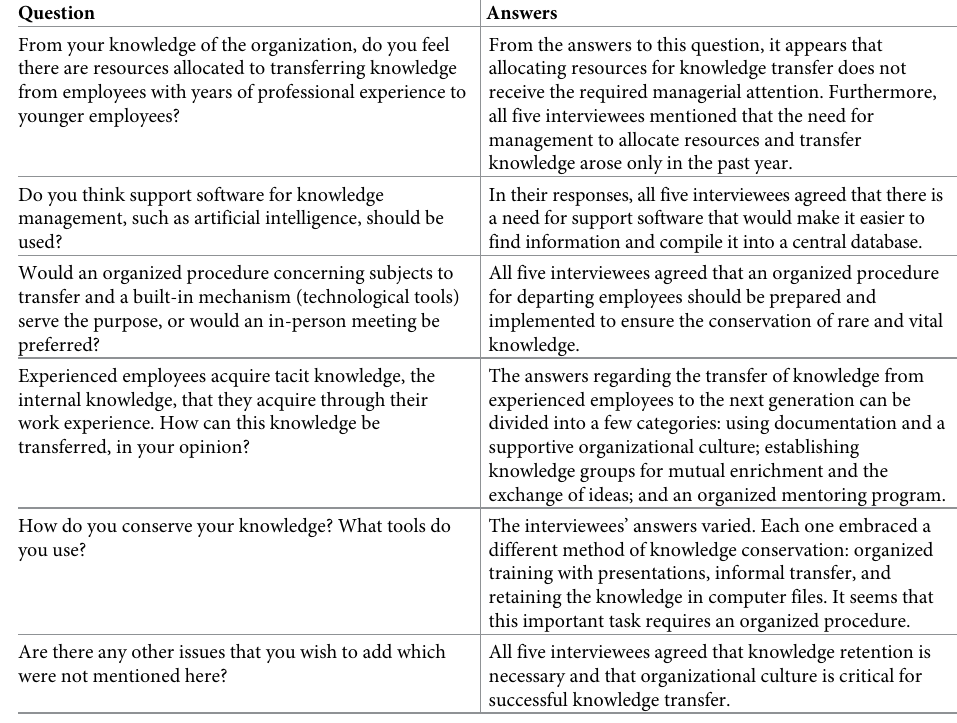
Table 1. Summary of the answers given by